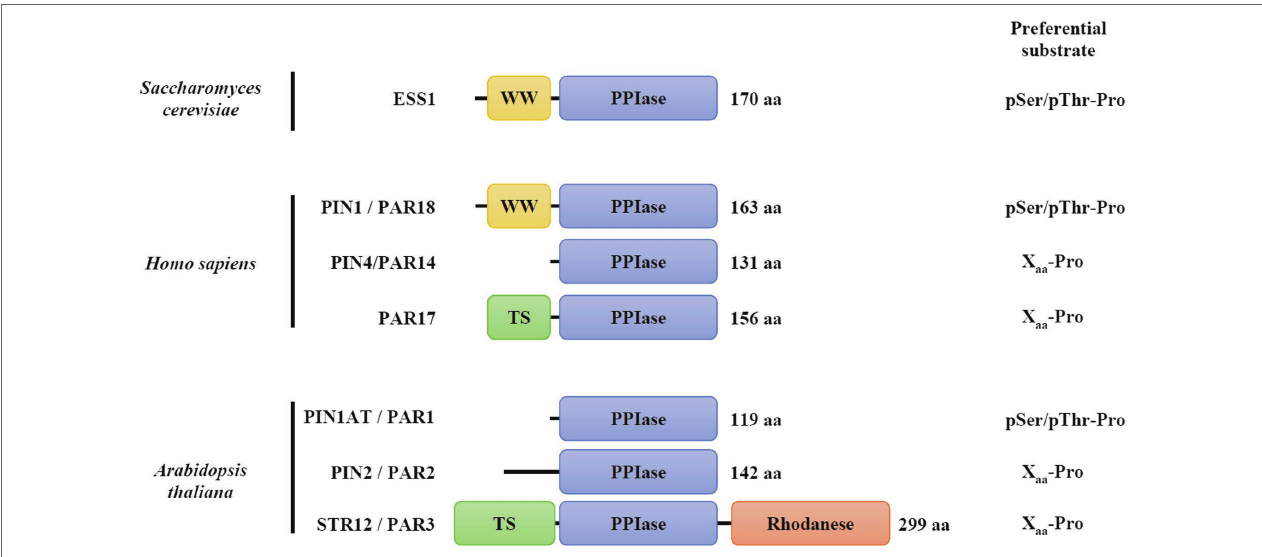
FIGURE 1 | Modular organization and substrate specificity of parvulin family members. The corresponding accession numbers are: Saccharomyces cerevisiae ESS1, P22696; Homo sapiens PIN1/PAR18, Q13526; H. sapiens PIN4/PAR14, Q9Y237; H. sapiens PIN4/PAR17, Q9Y237; and Arabidopsis thaliana PIN1At/PAR1, Q9SL42; A. thaliana PIN2/PAR2, Q9FE18; A. thaliana PAR3/STR12, Q93WI0. TS refers to as targeting sequence to mitochondria in PAR17, or to chloroplasts in STR12/PAR3. Information about substrate preferences were retrieved from Fanghänel and Fischer